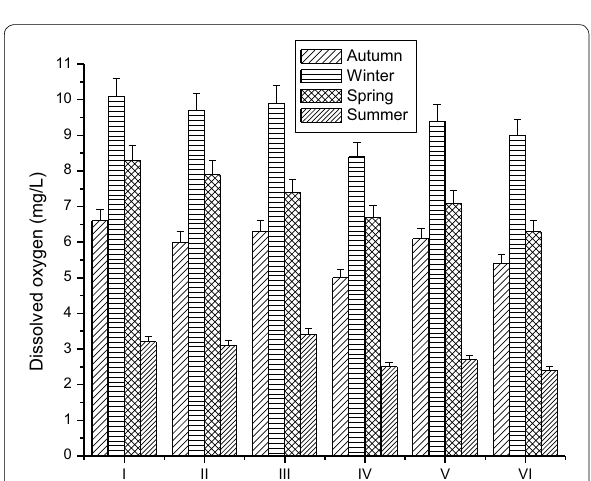
Fig. 7 Spatial and temporal variations of dissolved oxygen (mg/L) in Hokersar wetland during September 2012–August 2013